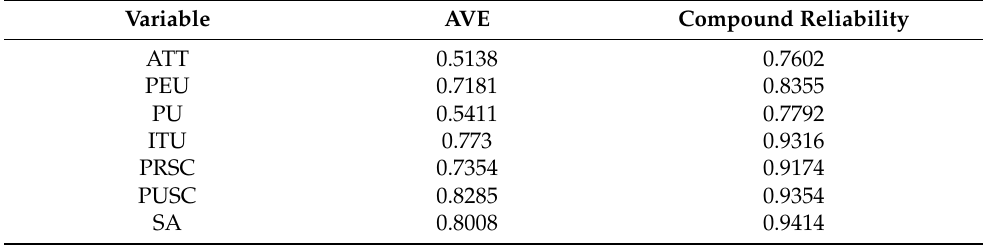
Table 2. Compound reliability and variance extracted from latent variables.